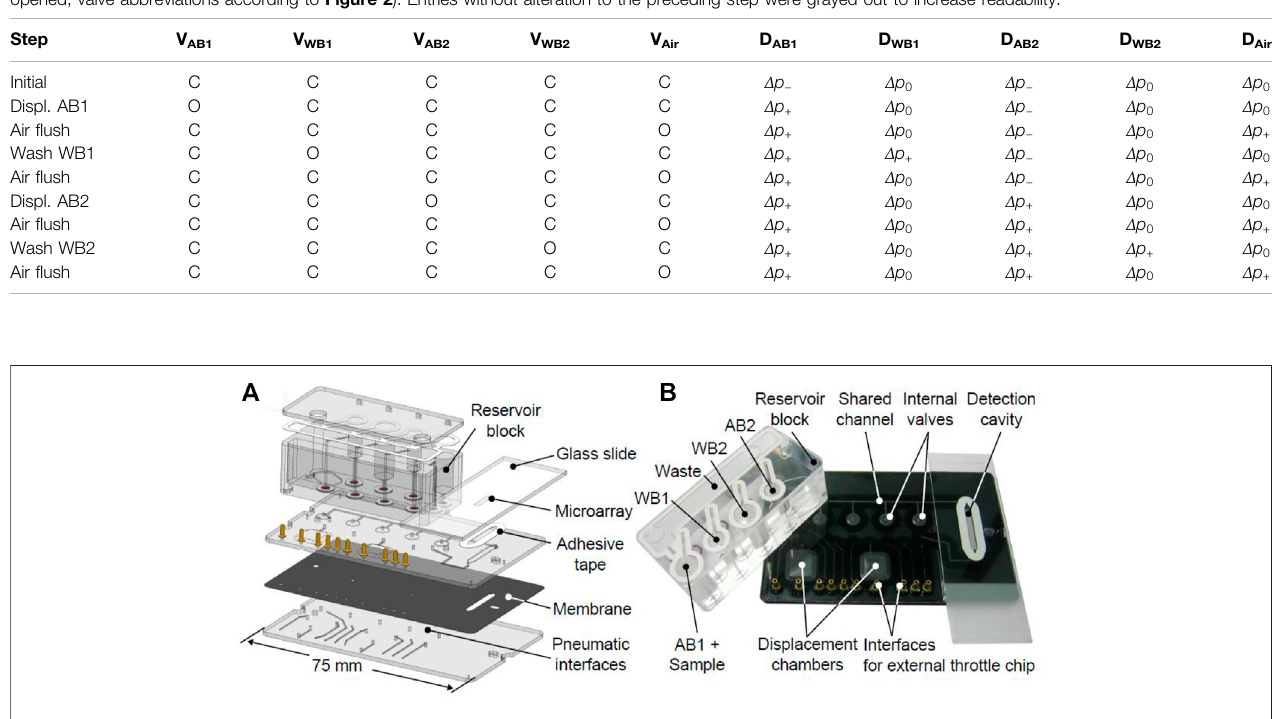
FIGURE3| Micro fl uidicsystemdevelopedforimmunoassayexperiments. (A) CADdrawingshowingpolymerwithdifferentlayersconstructed. (B) Photographofa fabricated